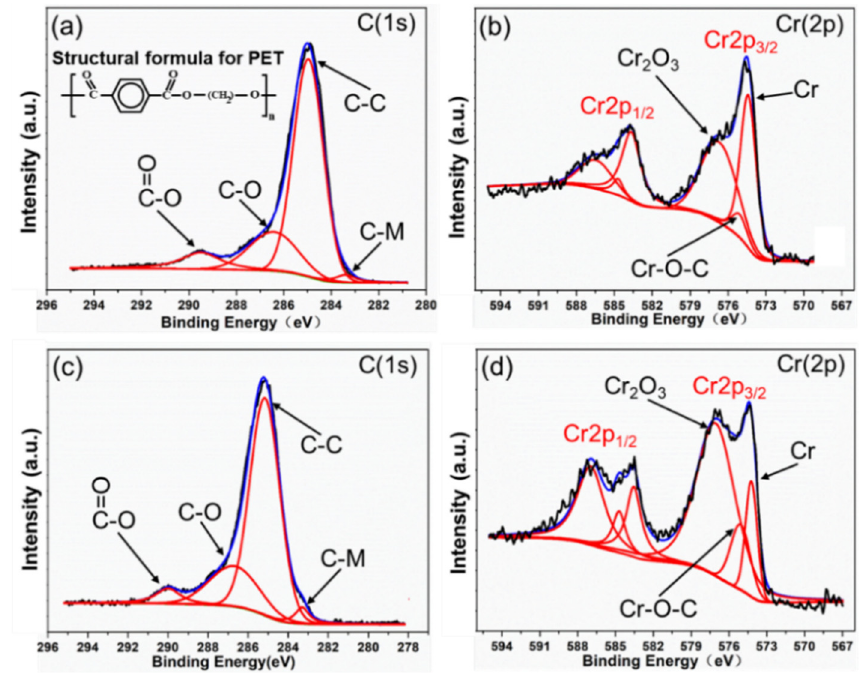
Figure 8. The XPS narrow scan spectrum of C and Cr elements: ( a ) C(1s) spectrum of O-LTJ, ( b ) Cr(2p) spectrum of O-LTJ, ( c ) C(1s) spectrum of O-LCJ, ( d ) Cr(2p) spectrum of O-LCJ.